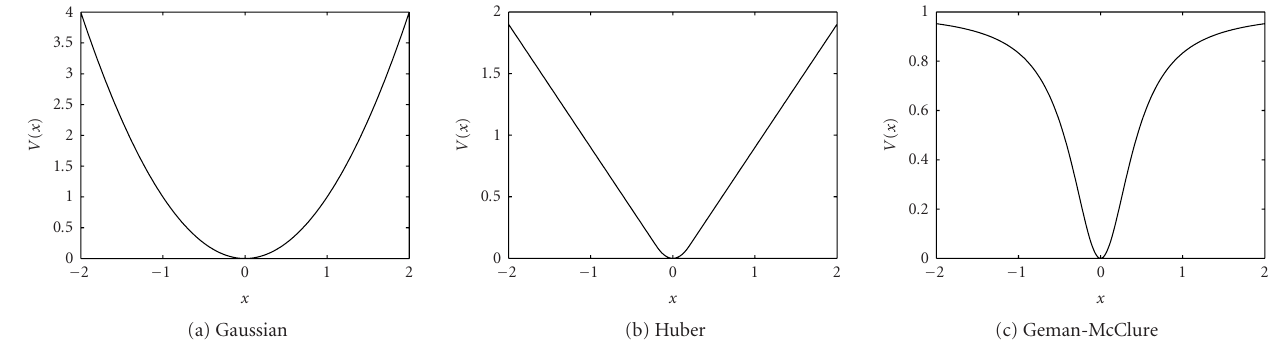
Figure 1: The potential functions of the Gaussian, Huber, and Geman-McClure